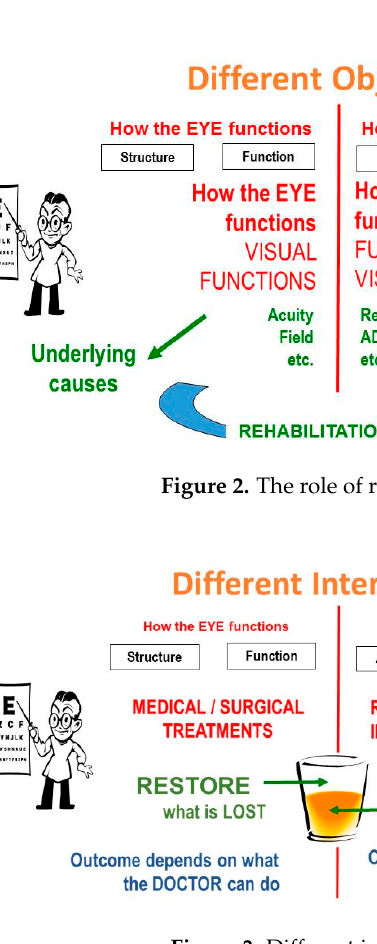
Figure 3. Different interventions.